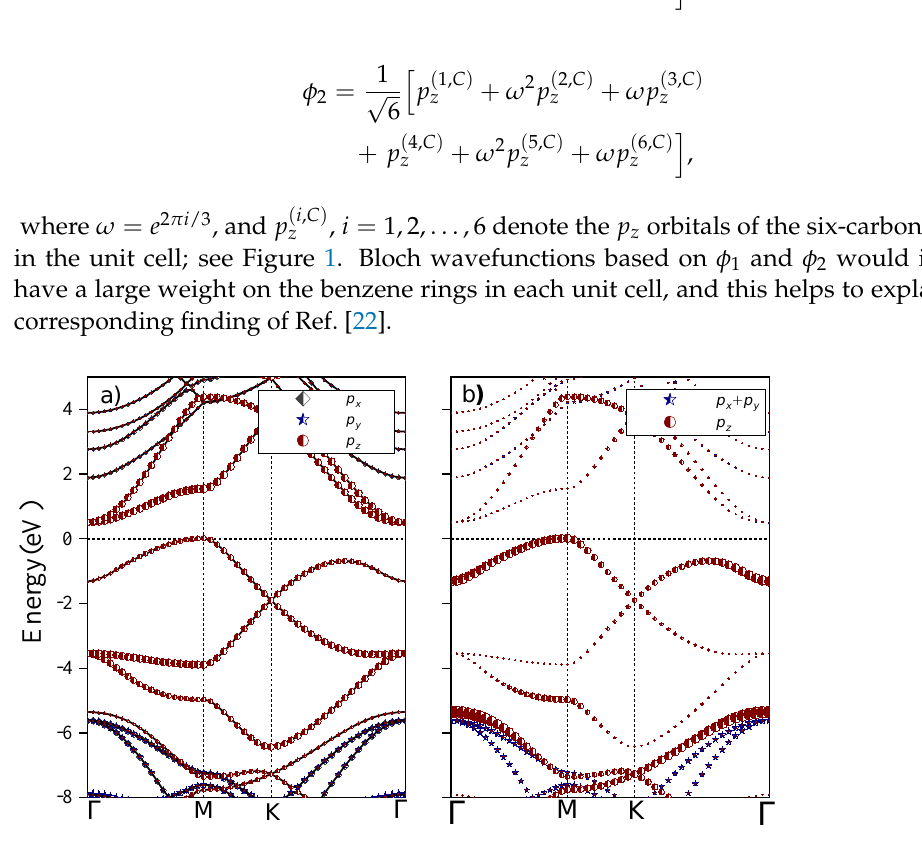
Figure 3. Atomic orbital weight of ( a ) carbon and ( b ) nitrogen atoms in the energy bands of C 3 N